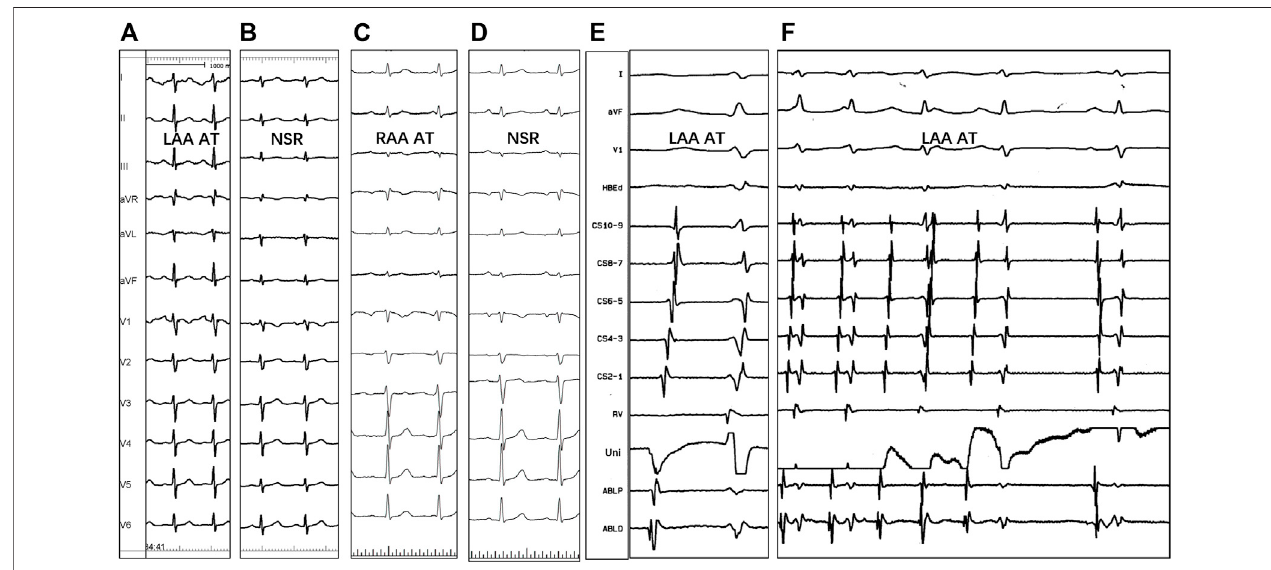
FIGURE 2 | P-wave morphology of the left (A,B) and right (C,D) atrial appendage tachycardias, the electrogram of successful ablation site (E) , and tachycardia termination with RF application (F) . NSR = normal sinus rhythm; Uni = unipolar electrogram; ABLP and ABLD = bipolar electrogram; Other abbreviations as previously.